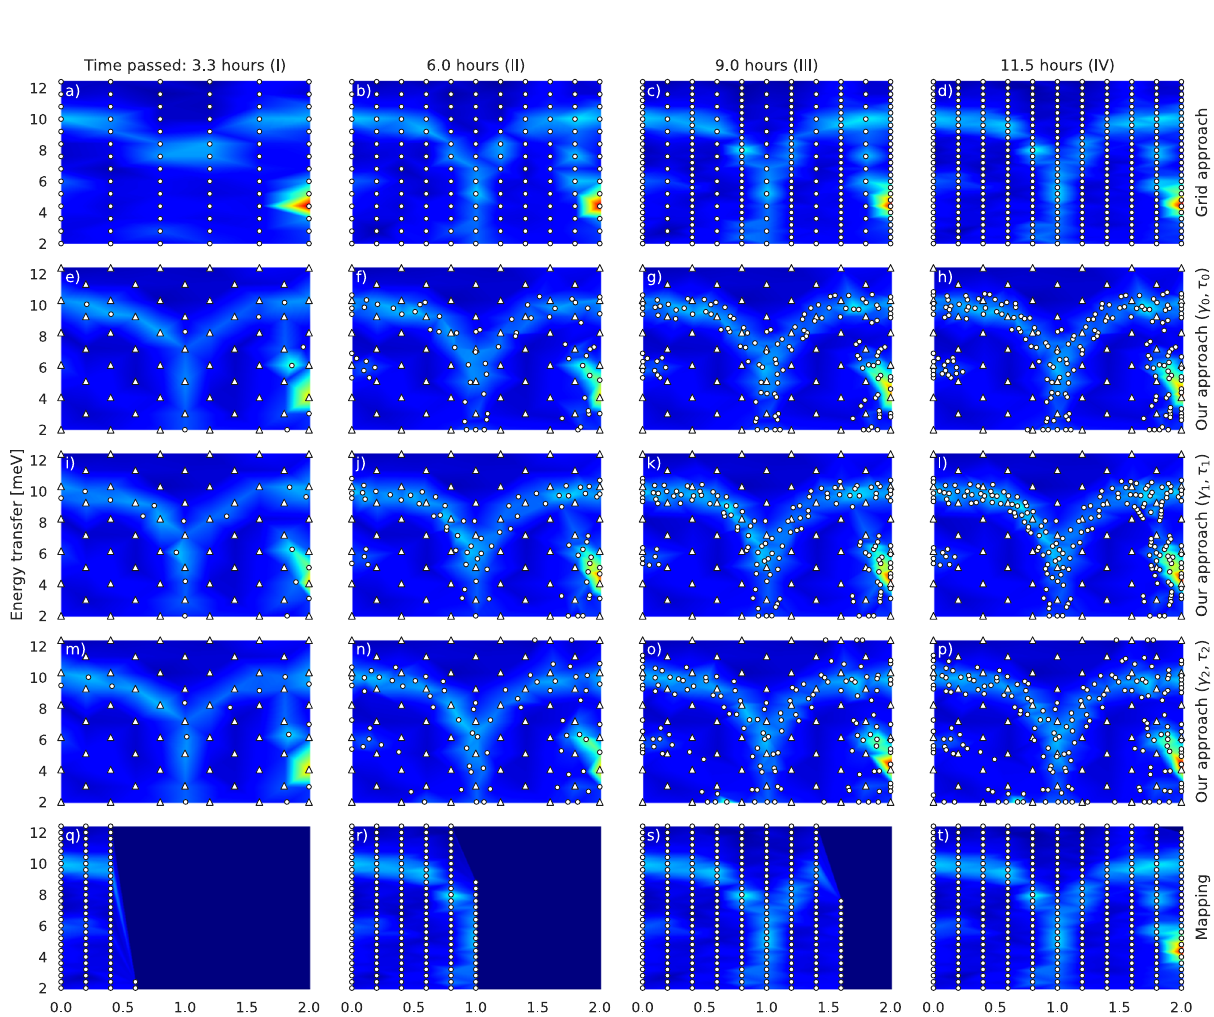
Fig. 3 | Transformationofa Gaussianprocessto a corresponding log-Gaussian process. The one-dimensional example intensity function i and its logarithm are displayed with dashed orange lines. a Gaussian process with observations (blue dots) oflog i and its uncertainties(lightblue area)around its mean function (solid